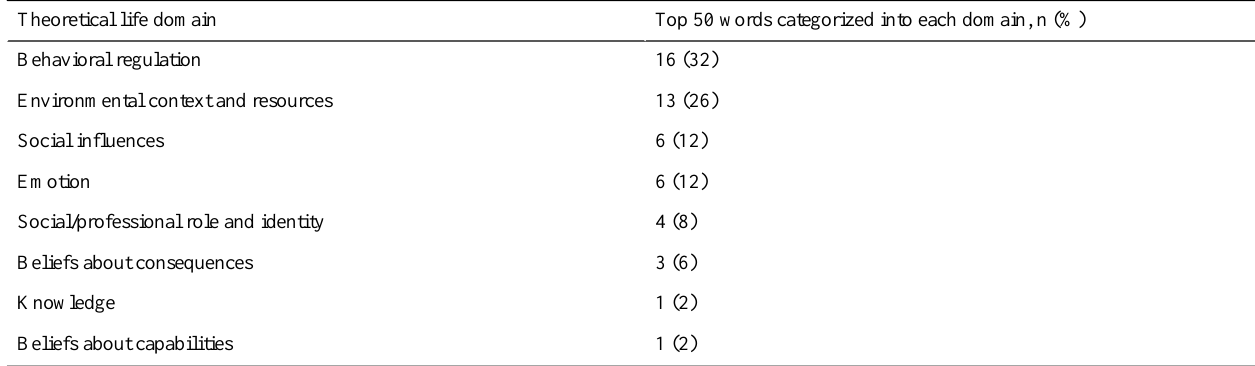
Table 2. Categorization of most frequently appearing words by theoretical life domain among impact stories from Australian adults in a cross-sectional study investigating the psychosocial impacts of COVID-19 in May 2020 (N=3483). Note: the theoretical life domains of skills, optimism, reinforcement, intentions, goals, and memory, attention, and decision processes were not identified in this data set. Top 50 words categorized into each domain, n (%)Theoretical life